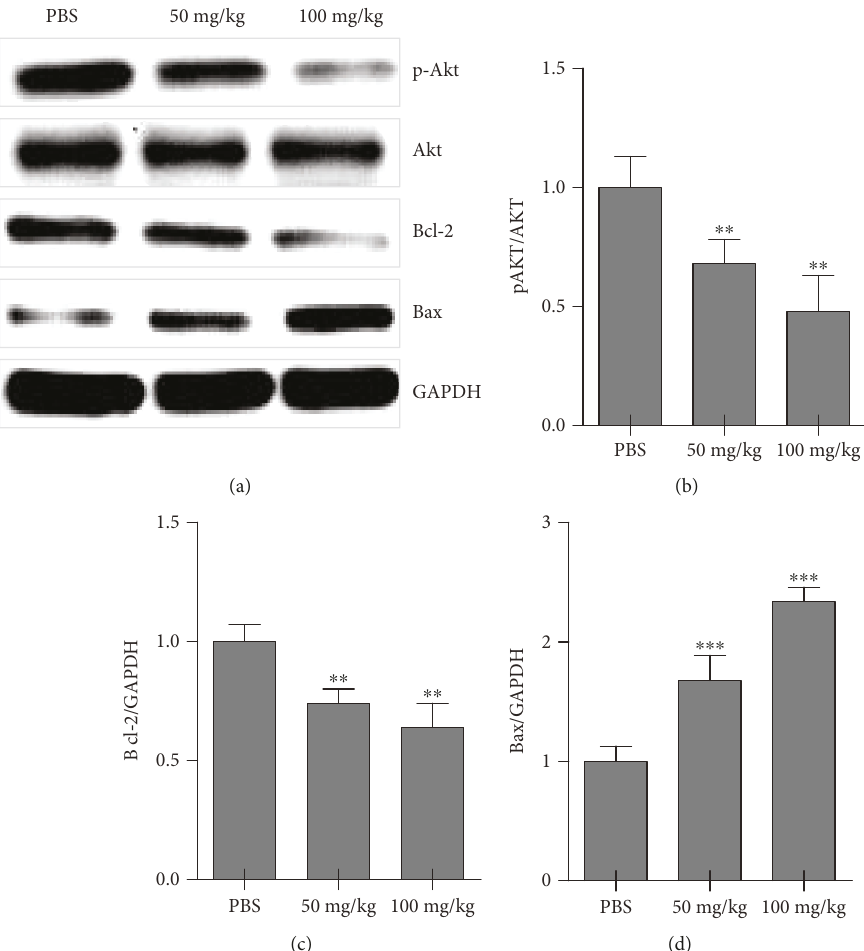
Figure 3: E ff ect on p-Akt, Akt, Bcl-2, and Bax protein levels induced by CPP. (a) The expression of p-Akt, Akt, Bcl-2, and Bax in tumor tissues are detected by immunoblotting. GAPDH is served as loading control. (b), (c), and (d) presented the relative expression of p-AKT, Bcl-2, and Bax proteins. Data were presented as mean ± SD from three independent experiments. ∗ p < 0 05 , ∗∗ p < 0 01 , and ∗∗∗ p < 0 001 compared with control. All experiments were performed